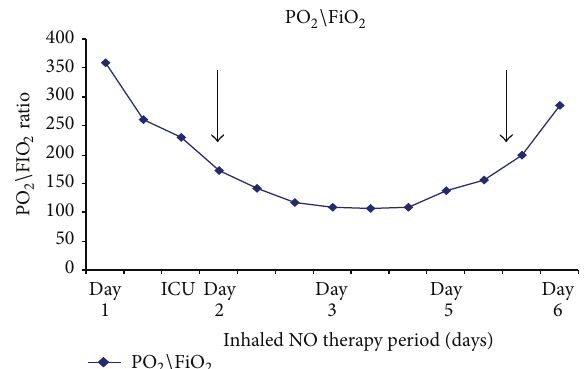
Figure 1: Changes in PO 2 /FiO 2 ratio during the first patient’s ICU stay. Inhaled NO therapy was initiated on the second day of the patient’s hospitalization (represented by the first black arrow) due to severe unresponsive persistent hypoxemia (PO 2 /FiO 2 -110). By the fourth day after hospitalization, the PaO 2 /FiO 2 ratio was improving and inhaled NO therapy was discontinued (represented by the second black